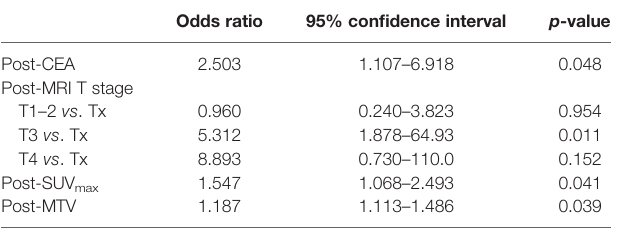
TABLE 2 | Multivariable regression models for pathologic complete response in the training group.